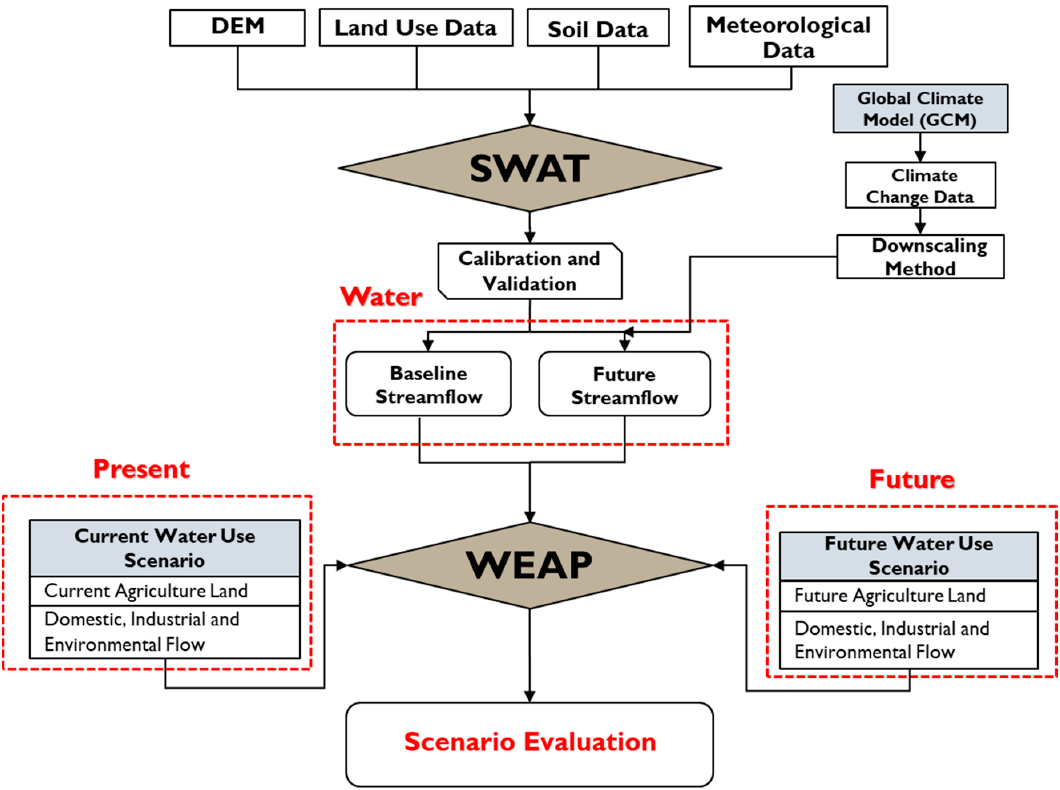
Figure 3. Model flowchart that illustrates the integration of the Soil and Water Assessment Tool (SWAT) and Water Evaluation and Planning (WEAP)